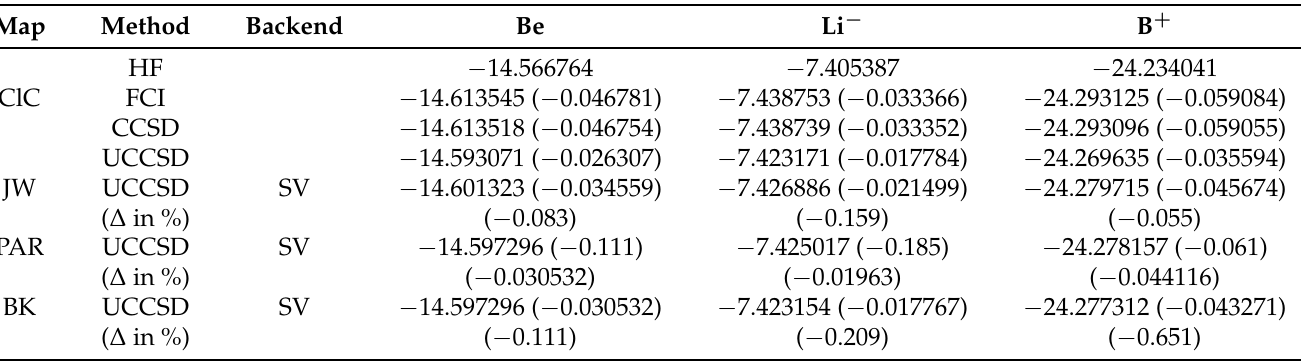
Table 4. Using the same notations as in Table 1, the ground state and correlation energies for Be, Li − , and B + in the 6-31G basis are